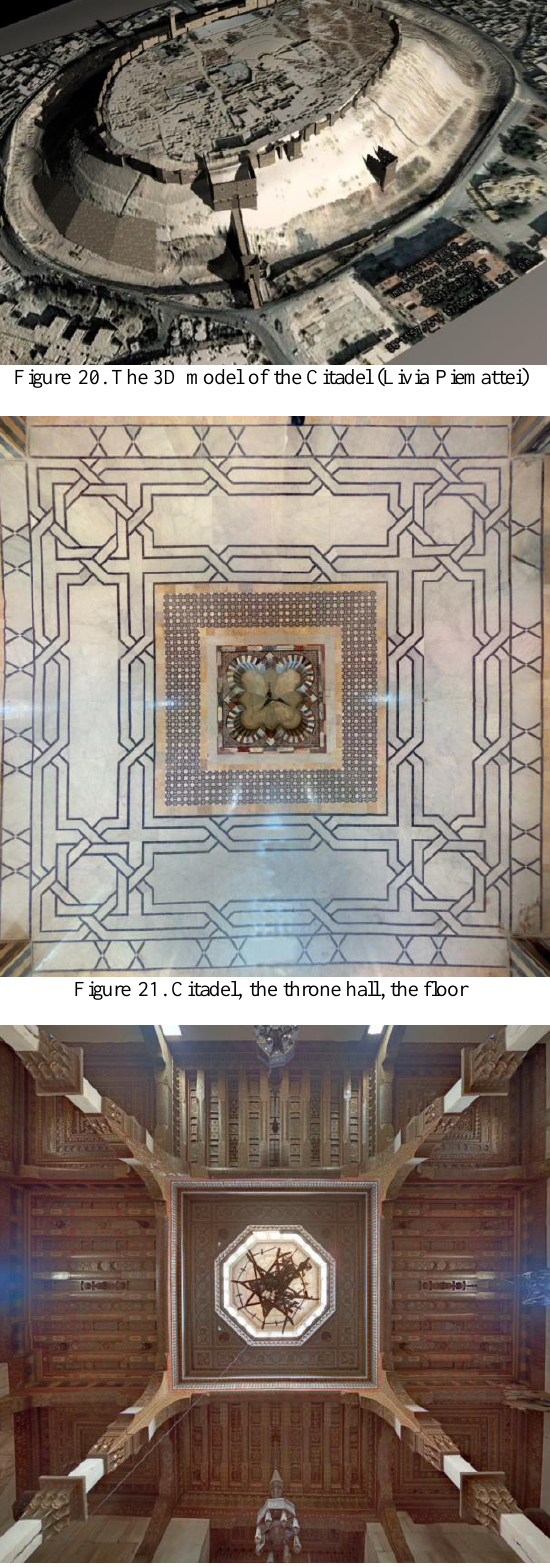
Figure 22. Citadel, the throne hall, the